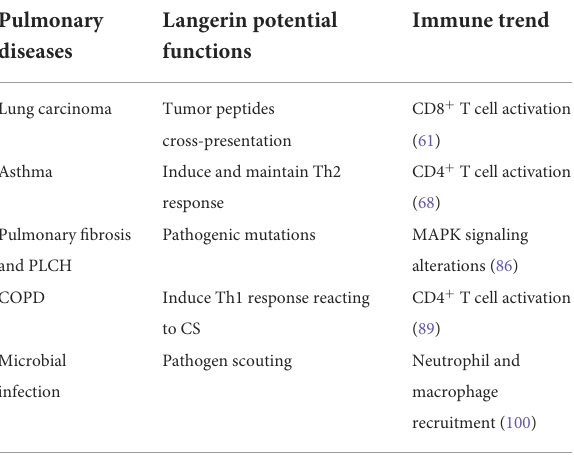
TABLE 1 Potential functions of langerin in pulmonary